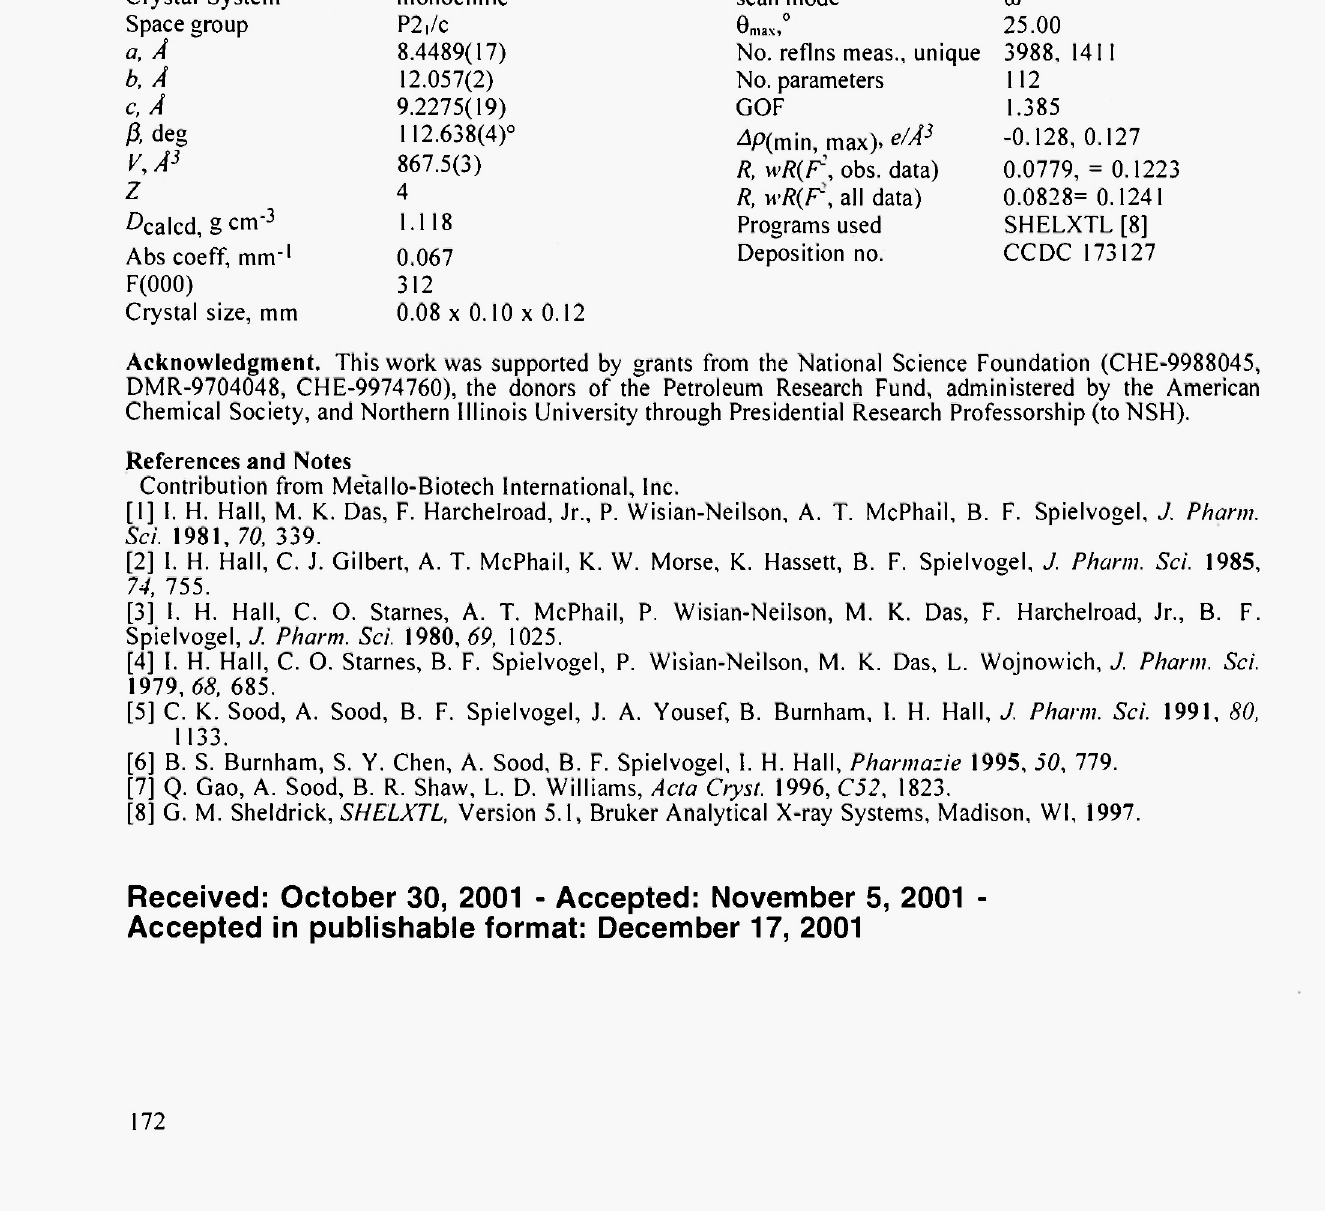
Table 1. Crvstallographic Data for o-Toluidinecvanoborane